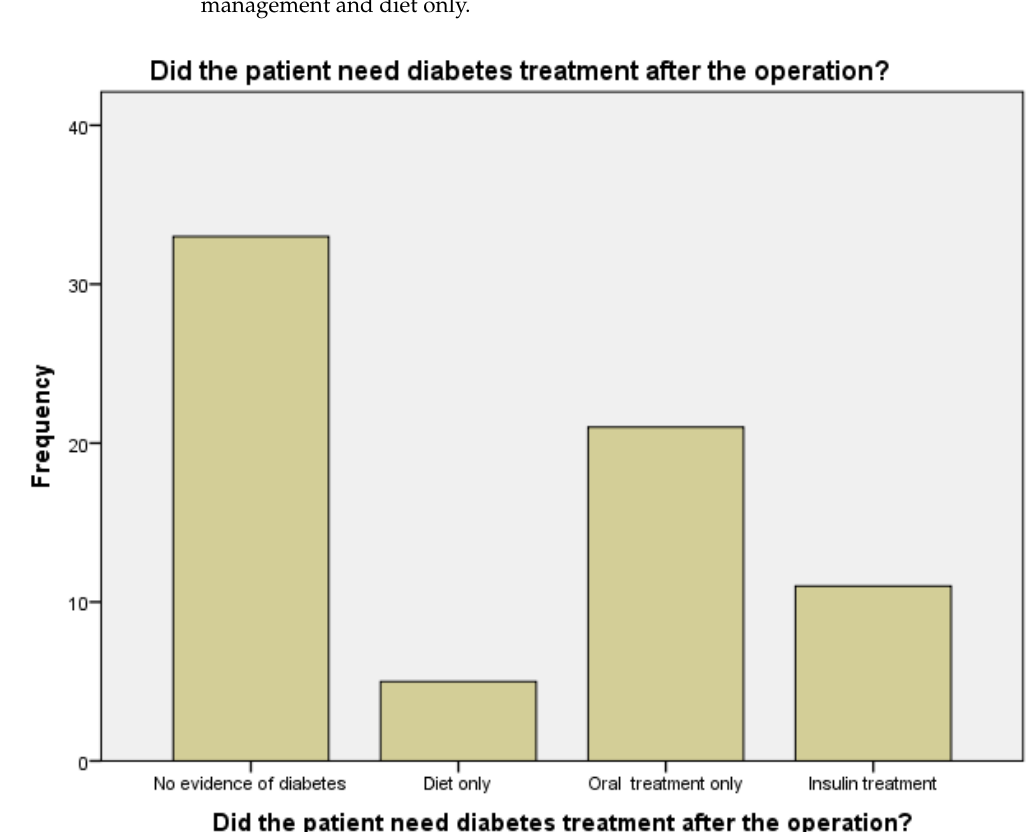
Figure 3. Diabetes mellitus (DM) status after the operation. Of the 70 patients, 39% had lost less than 25% of their excess body weight, while other patients lost more than 25% of their excess body weight. When looking at the group that had lost more than 25% of their excess body weight, there was a higher utilization of the band (95% vs. 70% in the lower reduction of band utilization; p = 0.011). Age and number of years with the band had no significant effect on excess weight loss. An interesting result was that there was no difference between those who lost more than 25% of their excess weight and those who lost less than that in the reduction of HbA1c, which means this is unrelated to the magnitude of the weight loss. Also, we did not find any correlation be- tween the HbA1c levels and the BMI decrease or the excess weight loss (no significant correlation was found between the HbA1c levels and delta BMI [r = − 0.105, p = 0.5], as well as total weight loss [r = − 0.083, p = 0.6]). Another interesting result was an improvement in other comorbidities such as HTN (50% did not need any HTN drugs 5 years after the operation) and Obstructive Sleep Apnea (OSA), which has clinically improved in 25% of the patients. When considering the subjective level, 29% of the patients felt a significant improvement in their self-esteem, and 43% felt a dramatic improvement. Forty-nine per- cent of the patients felt a significant improvement in their physical ability, and a signifi- cant correlation was found between the excess weight loss and the improvement in phys- ical ability ( r = 0.421, p < 0.001). When considering weight in the interview, we found an inverse correlation between the current weight and the BAROS score ( r = − 0.385, p = 0.001). A similar result was found between the BMI difference and the BAROS score ( r = 0.604, p < 0.001). Similarly, a significant difference was found in the total BAROS score between the group who lost less than 25% of their excess body weight and those who lost more (1.6 vs. 3.3; p < 0.001). A summary of the quality-of-life instances is depicted in Table 2.